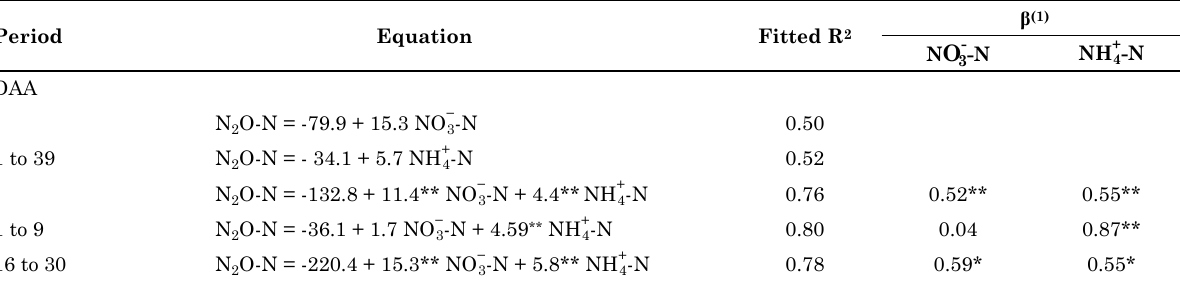
table 1. Simple and multiple regression analyses between N 2 o-N emission (µg m -2 h -1 ) and No - 3 -N and/or whole measurement period (1 to 39 days after application-daa), the initial (1 to 9 daa) period, and